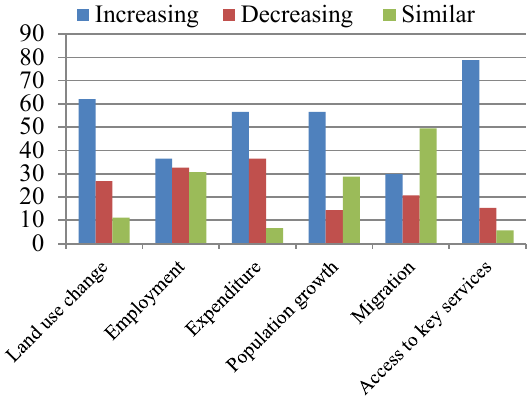
Figure 2. Social contributions of small-scale plantations in percent (n =